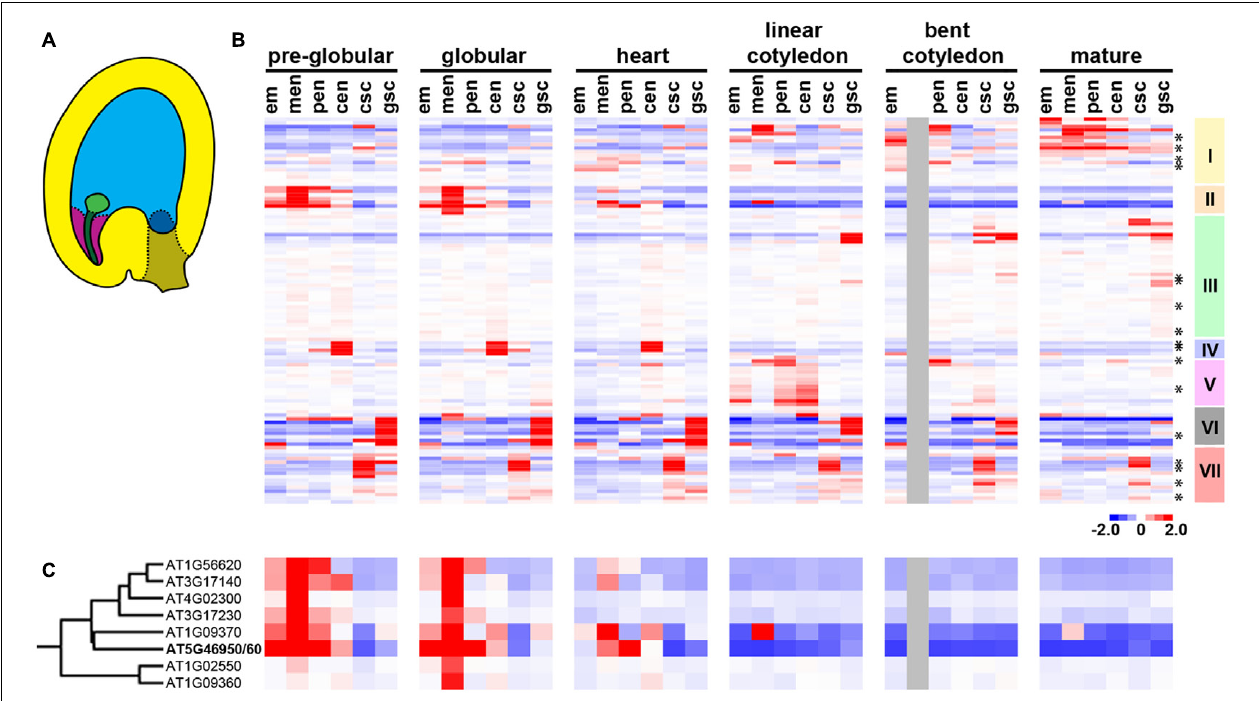
FIGURE 1 | The expression pattern of invertase and members of the InvINH/PMEI superfamily during seed development. (A) Illustration depicting a globular stage seed containing embryo proper (light green), suspensor (dark green), chalazal seed coat (brown), general seed coat (yellow), as well as micropylar (purple), peripheral (light blue), and chalazal (dark blue) endosperm. (B) Hierarchical clustering of 35 seed samples (in columns) and 107 genes (in rows), including 17 invertases (indicated by asterisks) and 90 InvINH/PMEIs. The early developmental transition in the embryo and the endosperm occurs at the heart stage. Developmental stages are indicated by the stage of embryo development. Each stage includes six seed compartments arranged from left to right as embryo proper (em), micropylar endosperm (men), peripheral endosperm (pen), chalazal endosperm (cen), chalazal seed coat (csc), and general seed coat (gsc). The color represents gene expression level relative to the median level of expression across all samples. Red, high expression; blue, low expression; gray, data not available. Seven clusters of co-regulated genes (I–VII) were identified based on the gene dendrogram. (C) A zoomed-in heatmap for Cluster II genes with the data points arranged in the same sequence as (B)